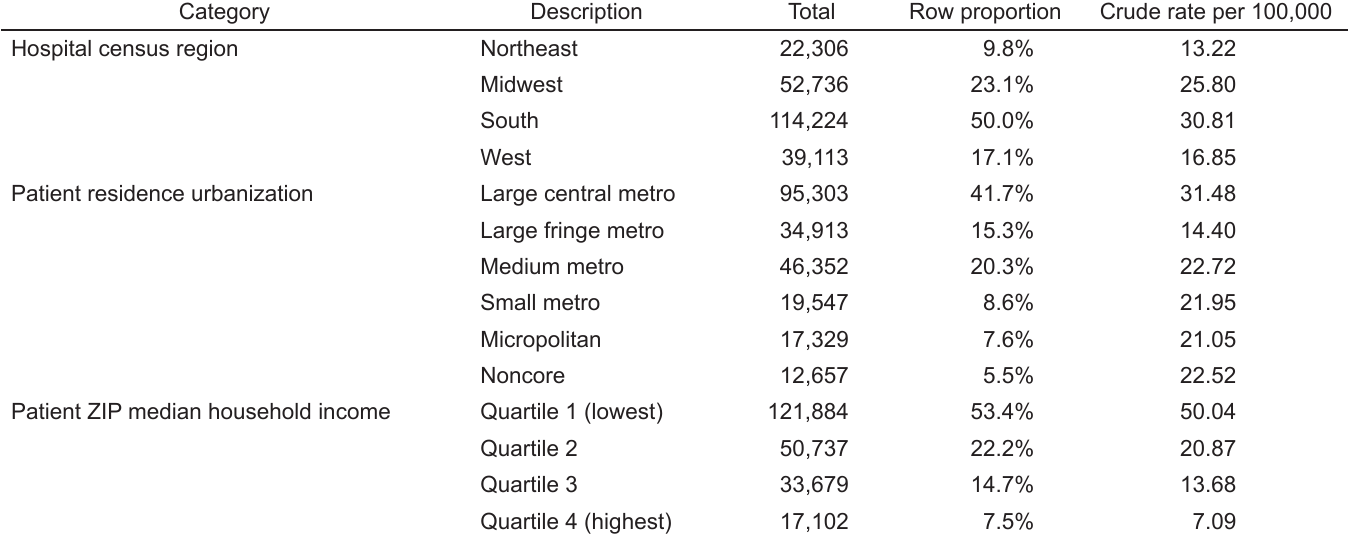
Table 2. Number, row proportion, and rate per 100,000 population by community characteristics for nonfatal firearm injury episodes for the United States, 2016-2018, based on emergency department discharges from the Nationwide Emergency Department Sample and inpatient hospital discharges from the National Inpatient Sample. Population from Healthcare Cost and Utilization Project